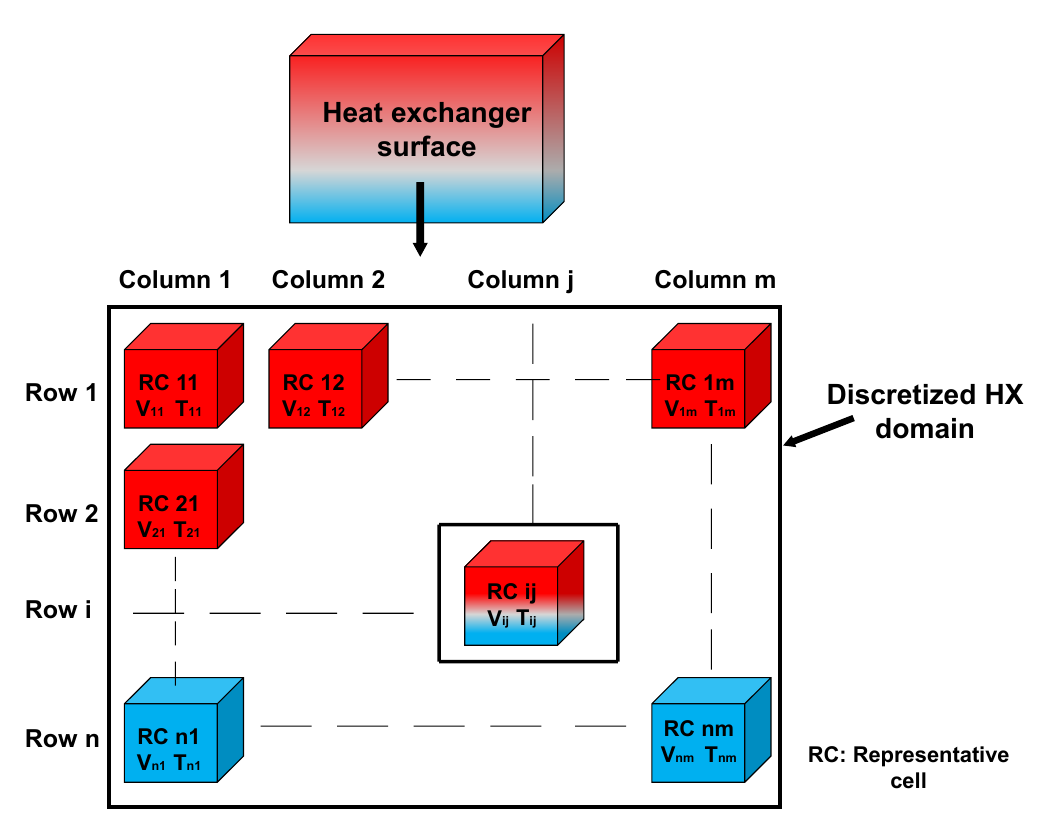
Figure 4. Splitting of the heat exchanger area into multiple RCs.